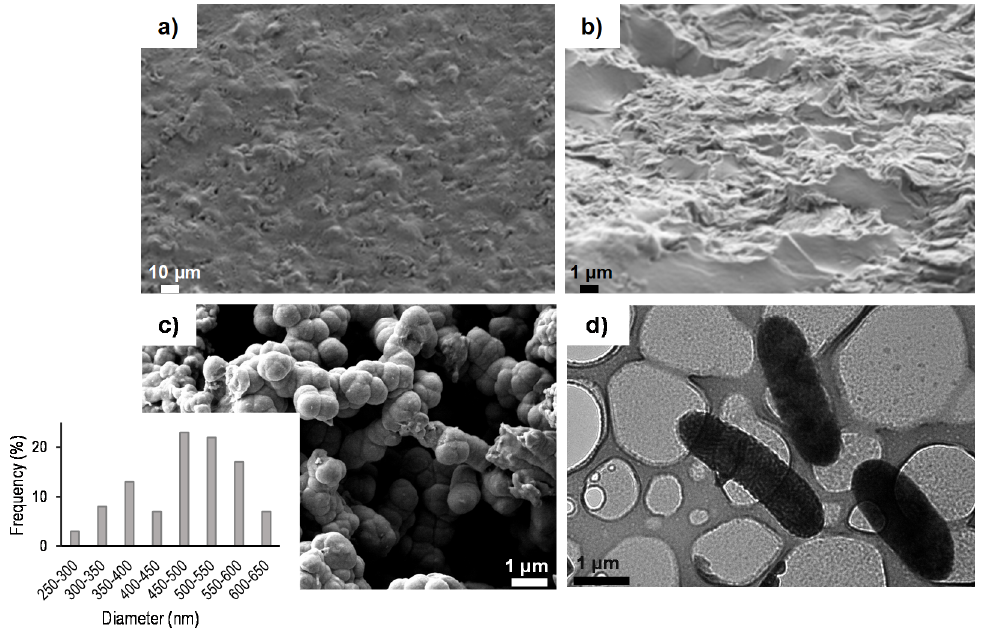
Figure 1. High-resolution field-emission scanning electron microscope (HR-FESEM) photomicrographs of semi-interpenetrating polymer network (IPN) poly (3-hydroxybutyrate-co-3-hydroxyvalerate)/poly (vinyl alcohol) (PHBV/PVA E). ( a ) Surface and ( b ) cross-section. ( c ) HR-FESEM and ( d ) TEM photomicrographs of polypirrole (PPy) nanoparticles. Inset in ( c ) shows the diameters’ distribution.